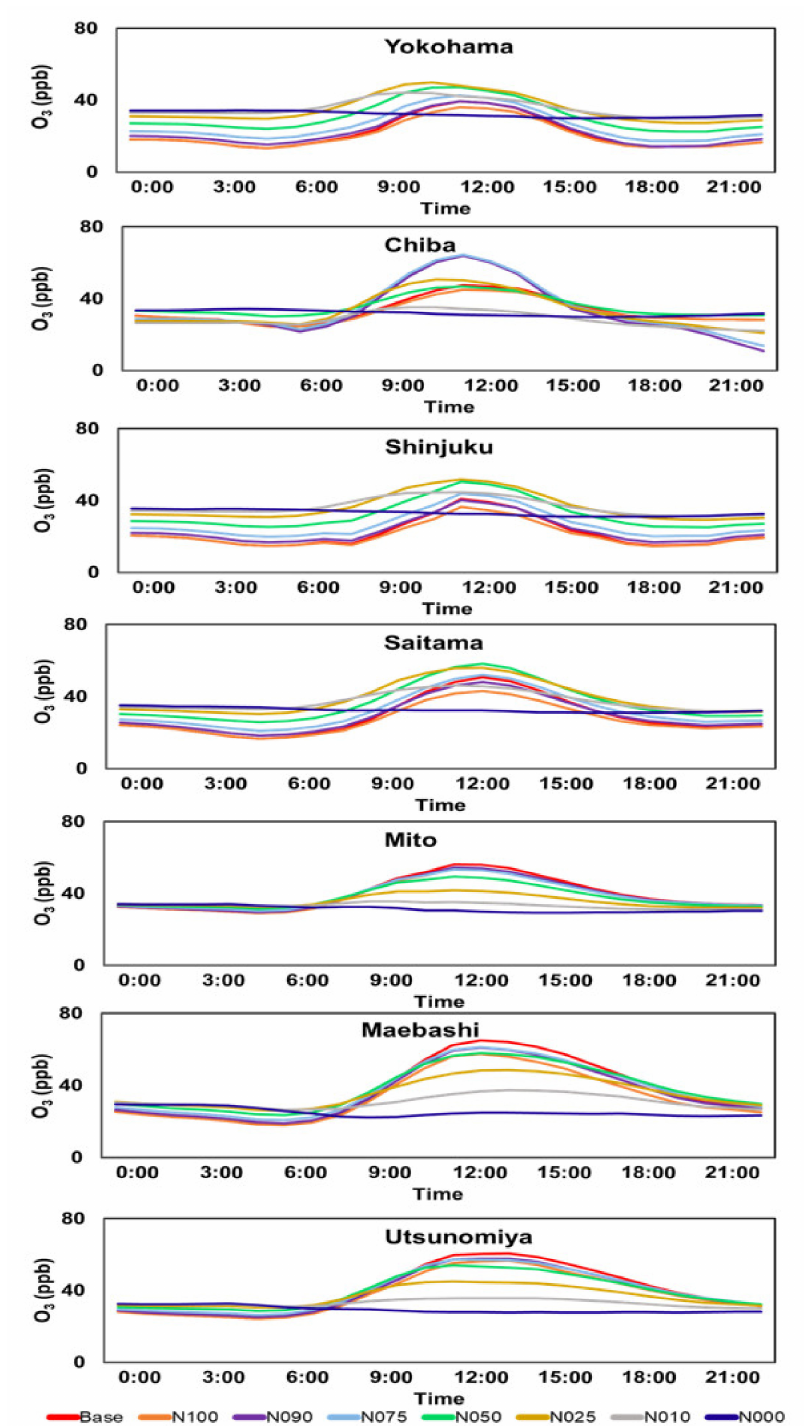
Figure 6. Average hourly concentrations of ozone in the simulated scenarios grouped by the percent- age of NO x reduction in seven points in